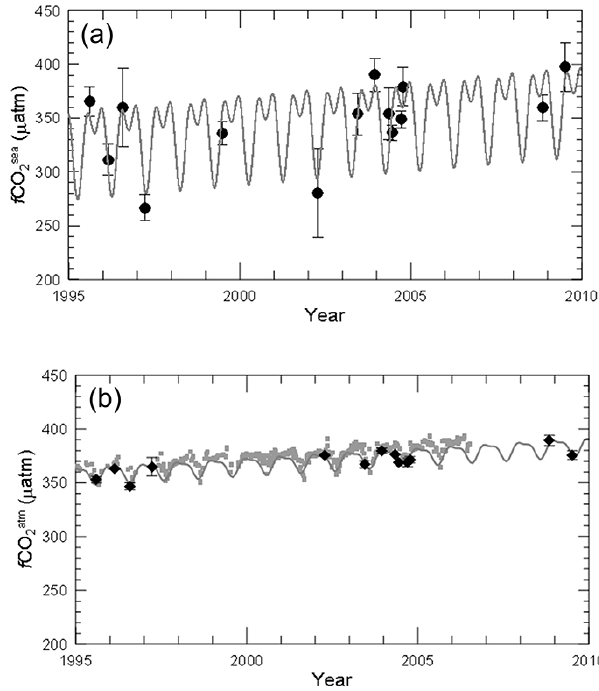
(filled circles) and f CO atm 2 2 Fig. 3. Long-term trend of f CO 2 at the Ulleung Basin from 1995 to 2009. (a) f CO sea (filled circles) of surface seawater of the Ulleung 2 Basin, (b) f CO atm (filled diamonds) of overlying atmosphere of the 2 Ulleung Basin. Atmospheric p CO 2 data, measured at Gosan, Jeju Island, South Korea (gray dots), are also shown for comparison with f CO atm . The gray curves represent f CO 2 fitted from a harmonic 2 function analysis by Eq.